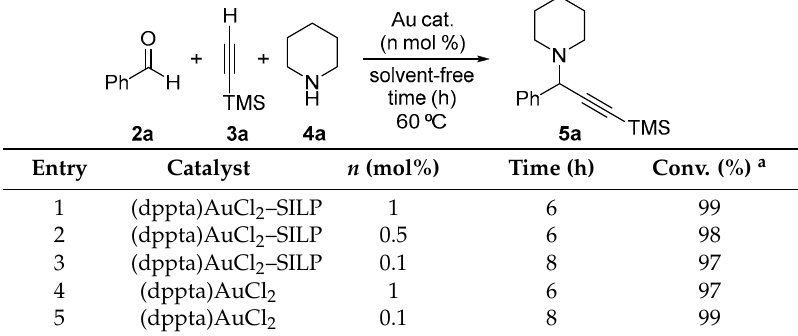
Table 1. Optimization of the A 3 coupling reaction of benzaldehyde, trimethylsilylacetylene, and piperidine.